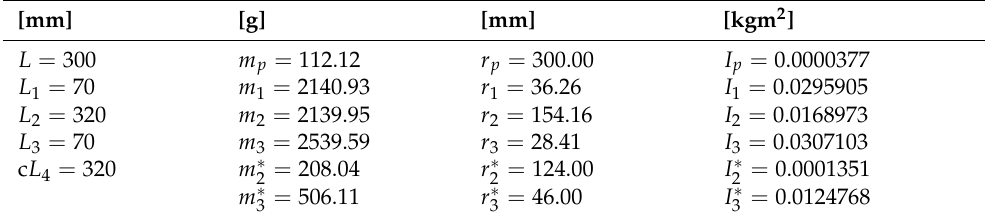
Table 2. Parameter values of the balanced